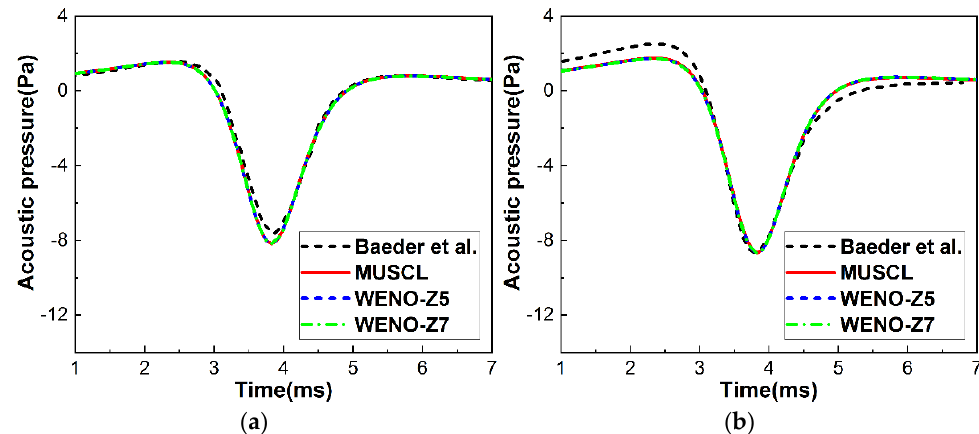
Figure 7. Comparison of the sound ‐ pressure time history in the plane of the rotor at 3.09 radii of the UH ‐ 1H model rotor for the WENO ‐ Z and the MUSCL schemes: ( a ) Thickness noise; ( b ) total noise. UH-1H model rotor for the WENO-Z and the MUSCL schemes: ( a ) Thickness noise; ( b ) total